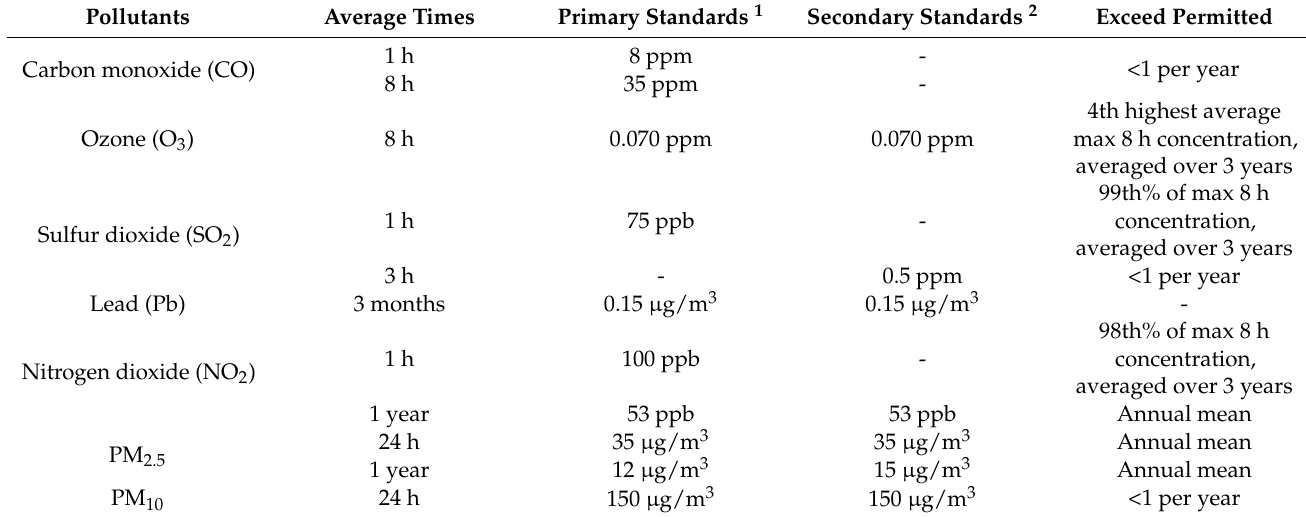
Table 7. National Ambient Air Quality Standards (NAAQSs) of United States